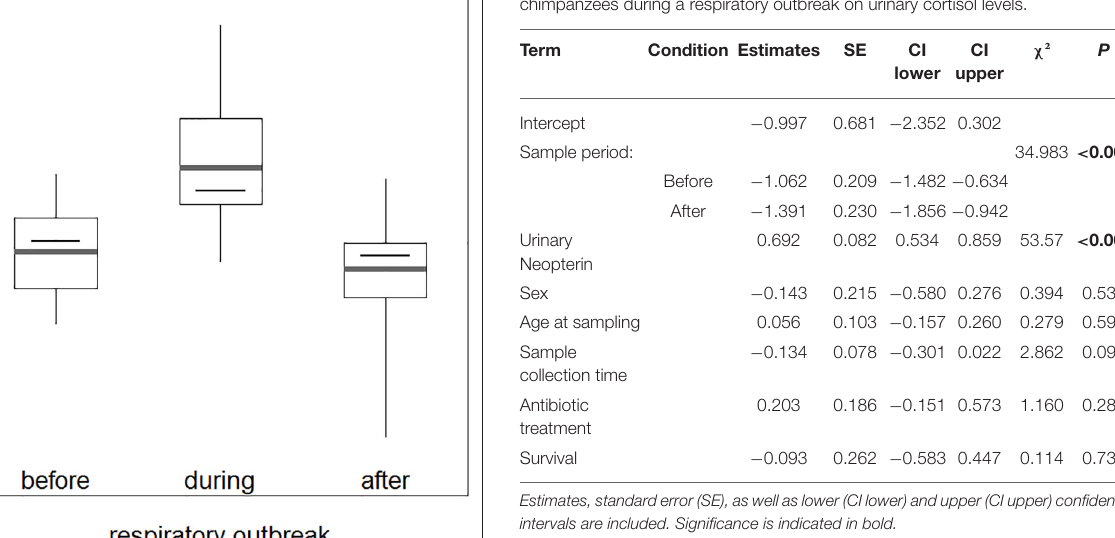
TABLE 2 | LMM results testing the influence of urinary neopterin, sampling period (before, during, and after the outbreak), age, and sex in sick and healthy wild chimpanzees during a respiratory outbreak on urinary cortisol levels.